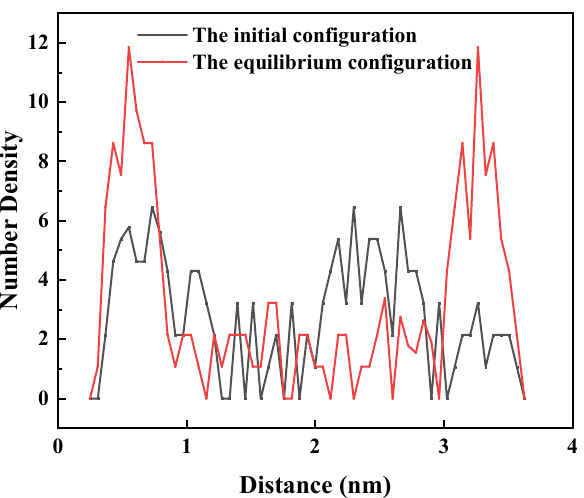
Figure 11. Number density profile of WMA additive molecules in the warm mix asphalt lubricating film along the z-axis.